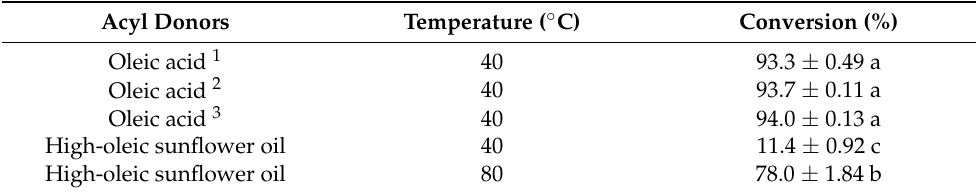
Table 1. DBSA-catalyzed reactions of cetyl alcohol with different acyl donors.